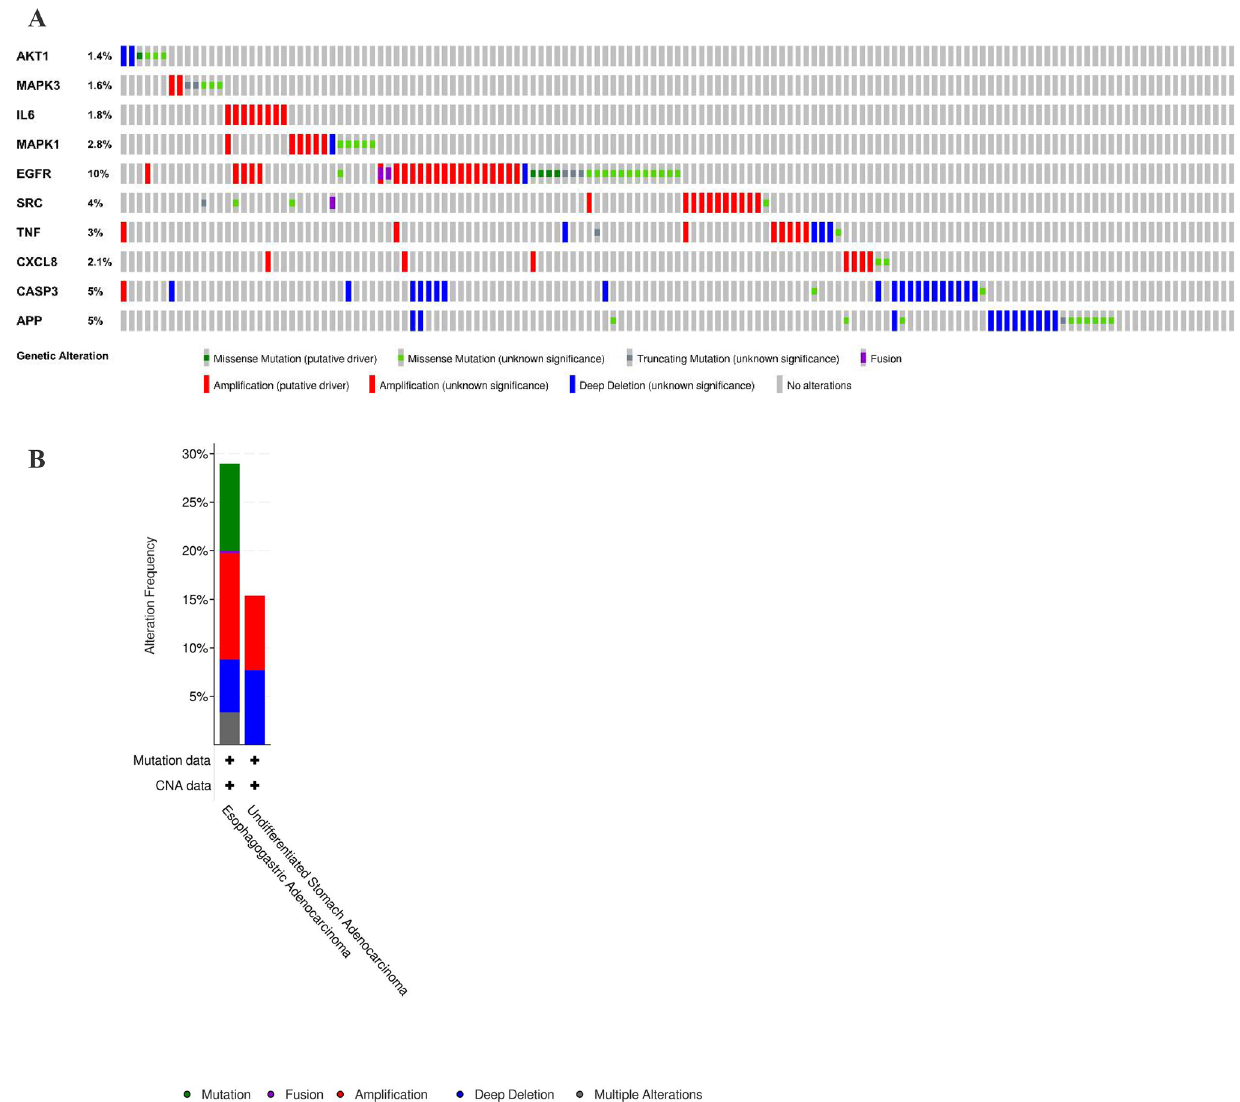
Figure 10. Genetic information of hub targets. ( A ) Data from TCGA of gastric adenocarcinoma showed that 124 of 434 patients (29%) had genetic mutations in these targets. ( B ) The diagram shows an overview of the genetic variation of the hub targets. ( C ) The diagram shows the correlation between the mRNA and protein levels of (a) AKT1, (b) MAPK3, (c) IL6, (d) MAPK1, (e) EGFR, (f) SRC, (g) TNF, (h) CXCL8, (i) CASP3, and (j)